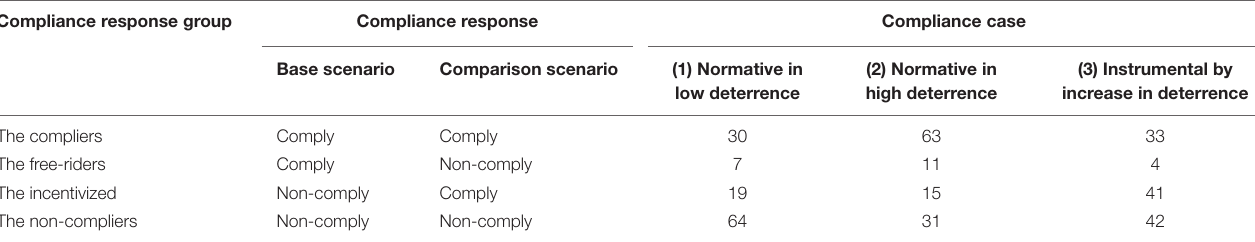
FIGURE 3 | Conceptual model of the research procedure. (A) Compliance decisions made in the base and comparison scenarios define the four compliance response groups (the compliers, the free-riders, the incentivized, and the non-compliers. (B) The research aims to identify a pattern in the five psycho-social characteristics of individuals in the four compliance response groups. TABLE 2 | Distribution of the number of participants within the four compliance groups for each of the compliance